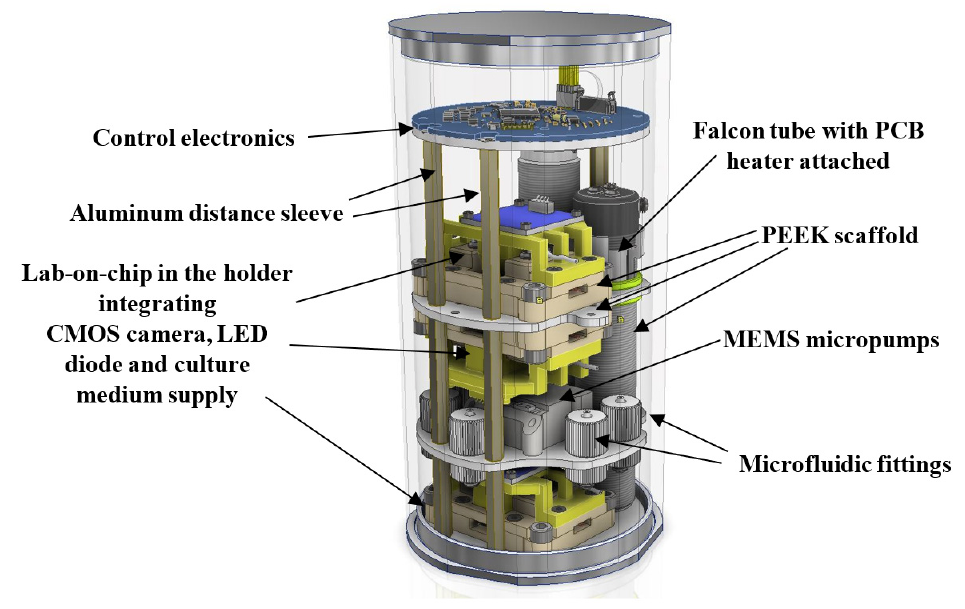
Figure 16. Microfluidic 2U payload for the biological nanosatellite cancer cells mission—concept.